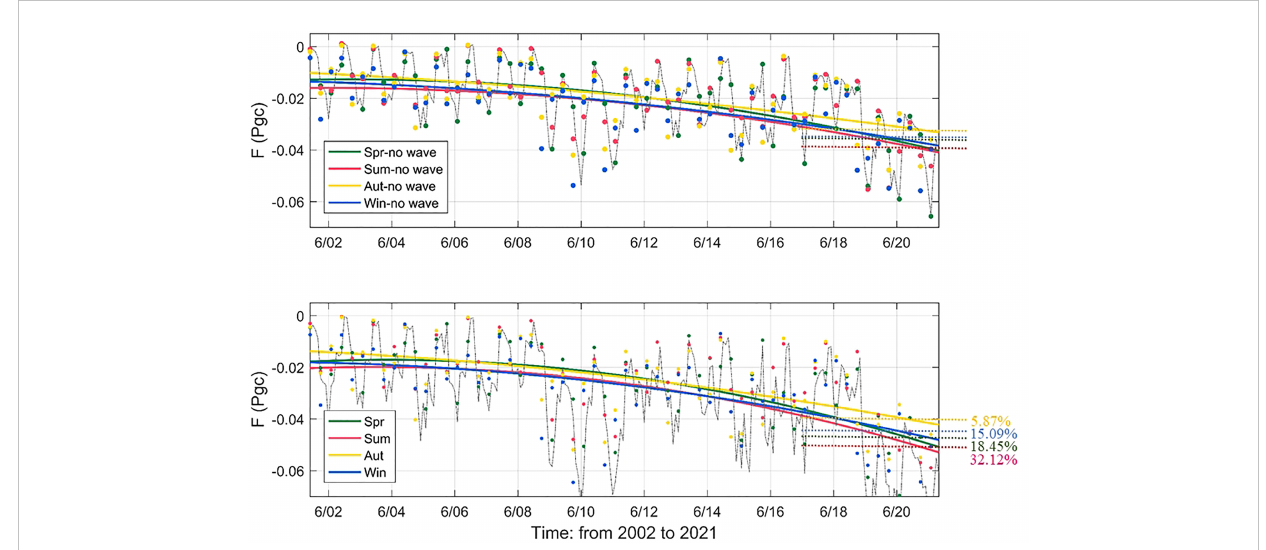
FIGURE 10 Evolution of air-sea net carbon fl ux, F net (PgC) with waves and no waves in the Southern Indian Ocean. The scattered points are seasonally averaged values integrated for the entire Southern Indian Ocean, and the lines are independent trends fi tted for the corresponding seasons.